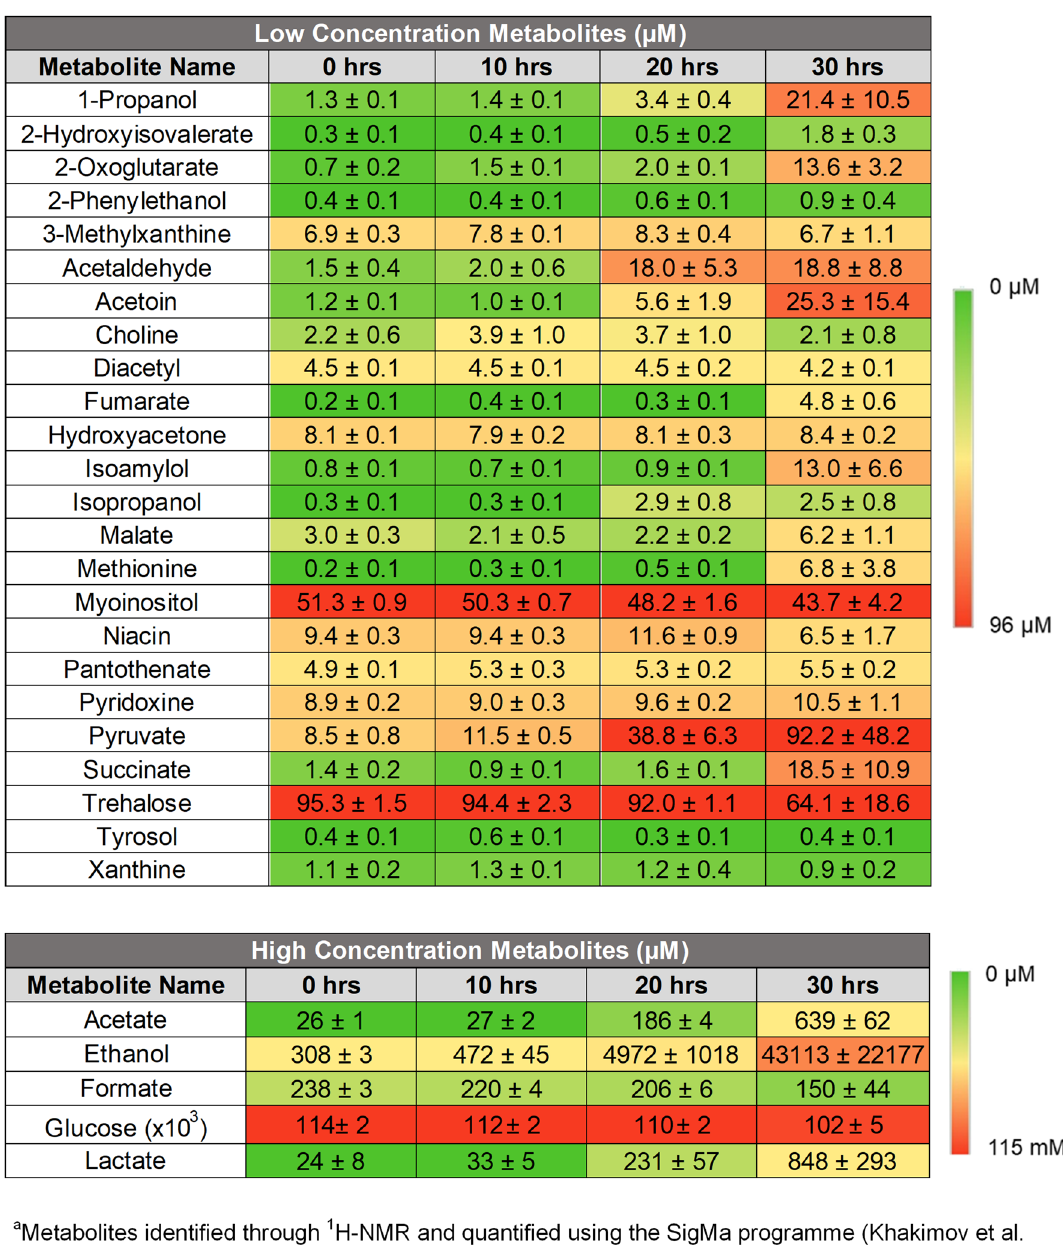
Table 2. Heatmap of the physiological concentrations of compounds detected under high nitrogen conditions during growth of S. cerevisiae strain Σ1278b a